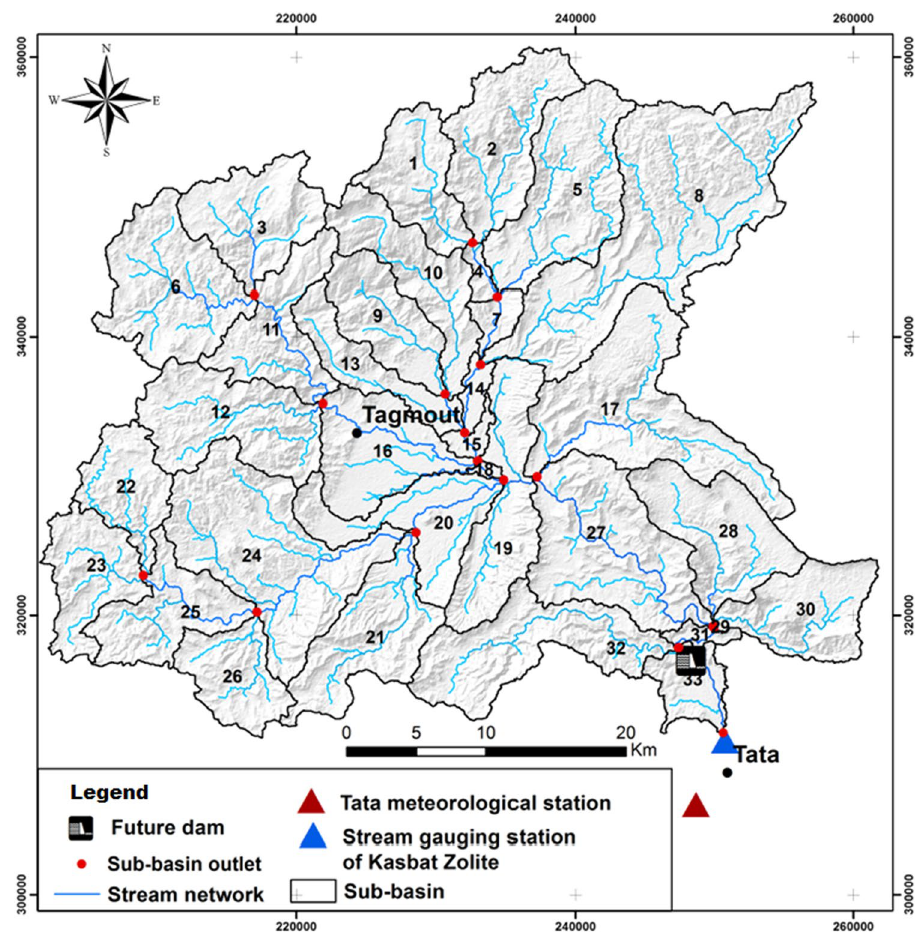
Table 2 Sensitive parameters and fitted values after calibration using SUFI-2